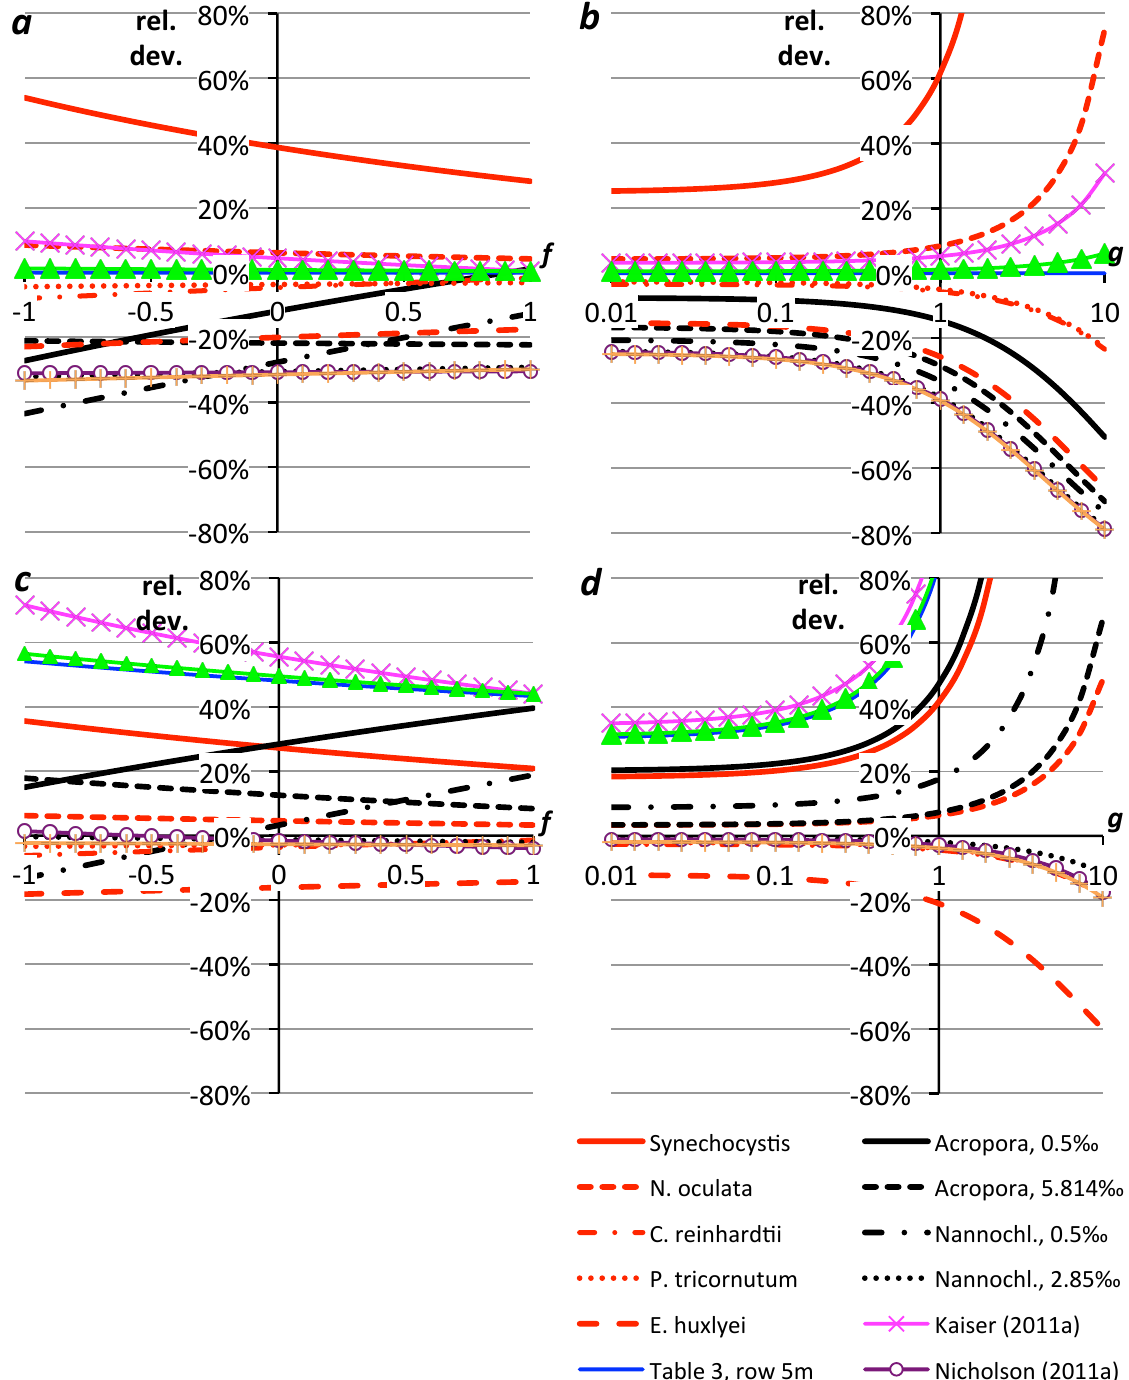
Fig. 1. Relative difference of g for different sets of 17 δ P , 18 δ P and γ R (Table 3) to g based on row 5m ( a , b ; Barkan and Luz, 2005) and row 6m ( c , d ; Barkan and Luz, 2011). ( a , c ) correspond to g = 0.4 and − 1 . 0 ≤ f ≤ 1.0; ( b , d ) to f = 0.1 and 0.01 ≤ g ≤ 10 (logarithmic axis). Red curves correspond to rows 5a–e ( a , b ) and 6a–e ( c , d ). “Kaiser (2011a)”, “Nicholson (2011a)”, “Acropora, 0.5‰”, “Acropora, 5.814‰”, “Nannochl., 0.5‰” and “Nannochl., 2.85‰” correspond to rows 1, 2, 3a, 3b, 4a and 4b. “Luz & B. (2011b)” uses 17 δ P = − 10.126‰ and 18 δ P = − 20.014 ‰ (Luz and Barkan,